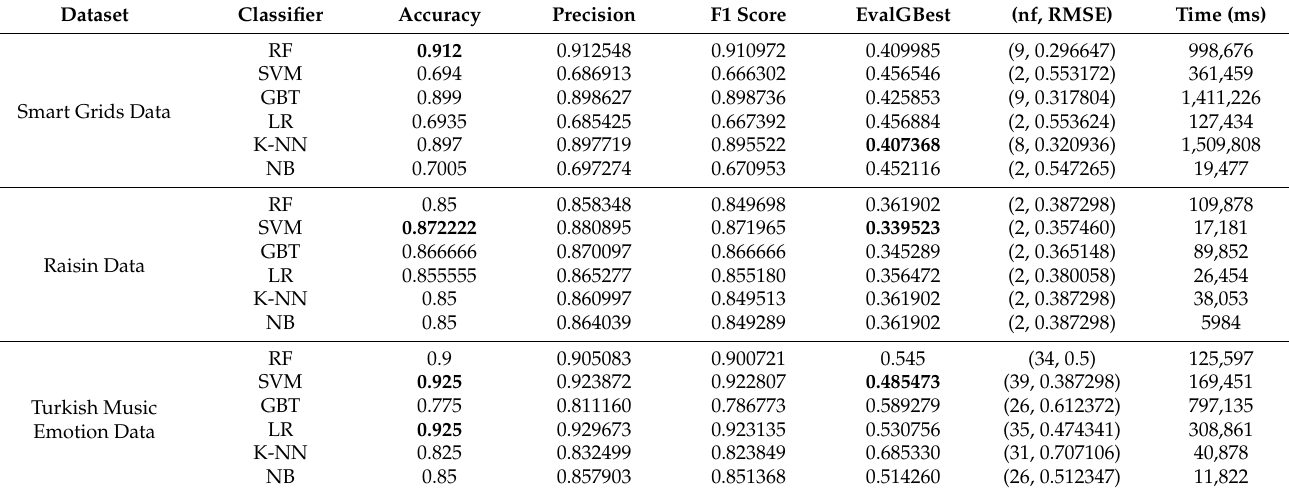
Table 4. BHOA Experimental Results